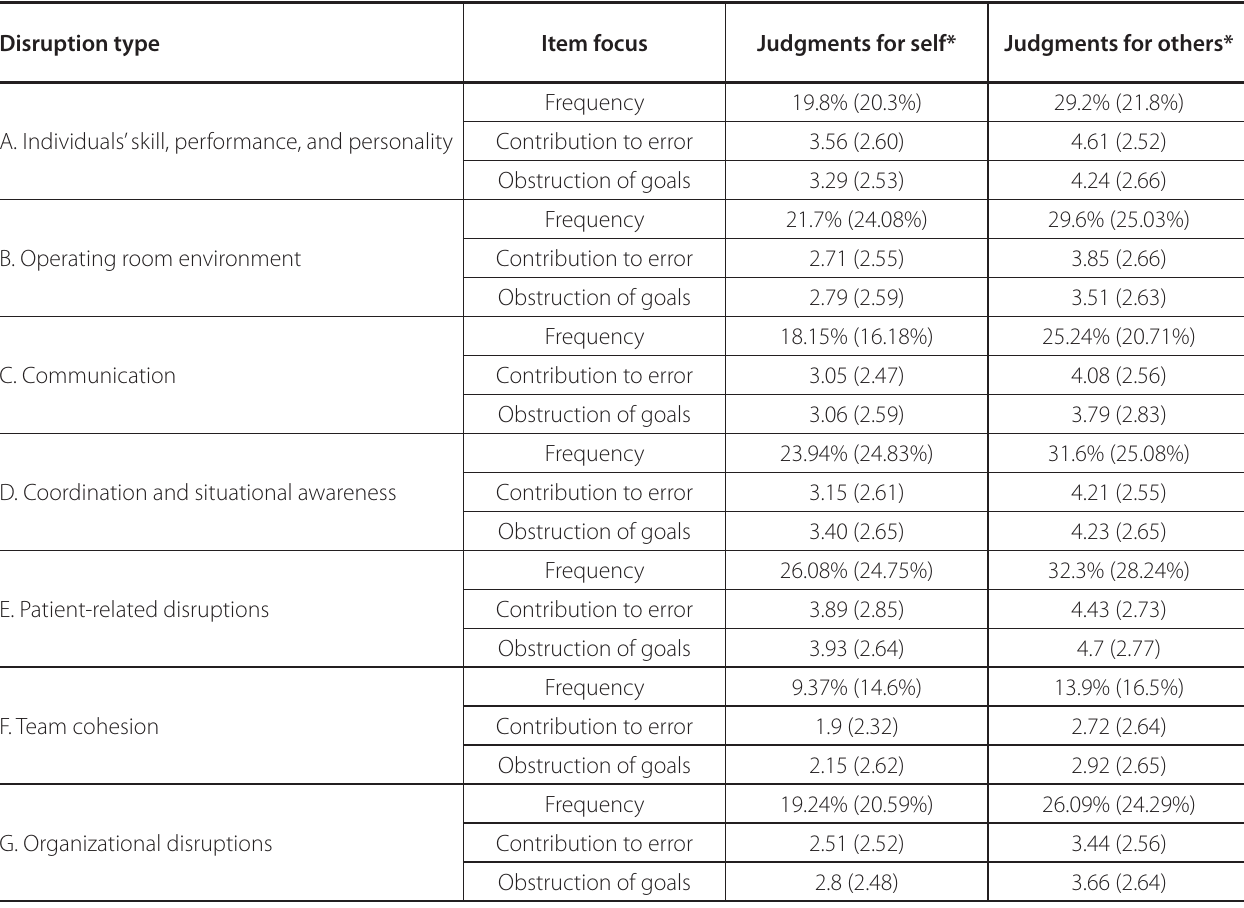
Table 1 . Descriptive analyses of self-judgments and judgments for others (n=43).